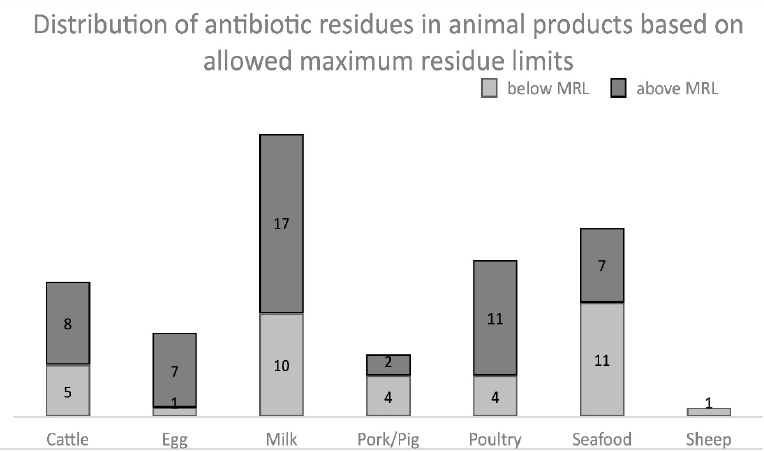
Figure 7. Distribution of antibiotic residues in animal products based on allowed maximum residue limits (MRL) regarding the 73 reviewed papers.